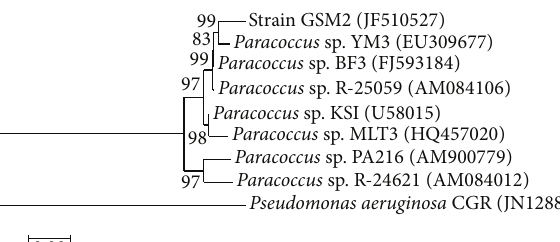
Figure 2: Phylogenetic tree of Paracoccus sp. GSM2 based on 16S rDNA analysis.